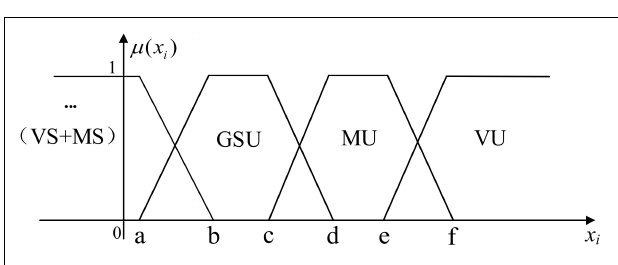
FIGURE 4 | Trapezoid membership function of decision attribute η